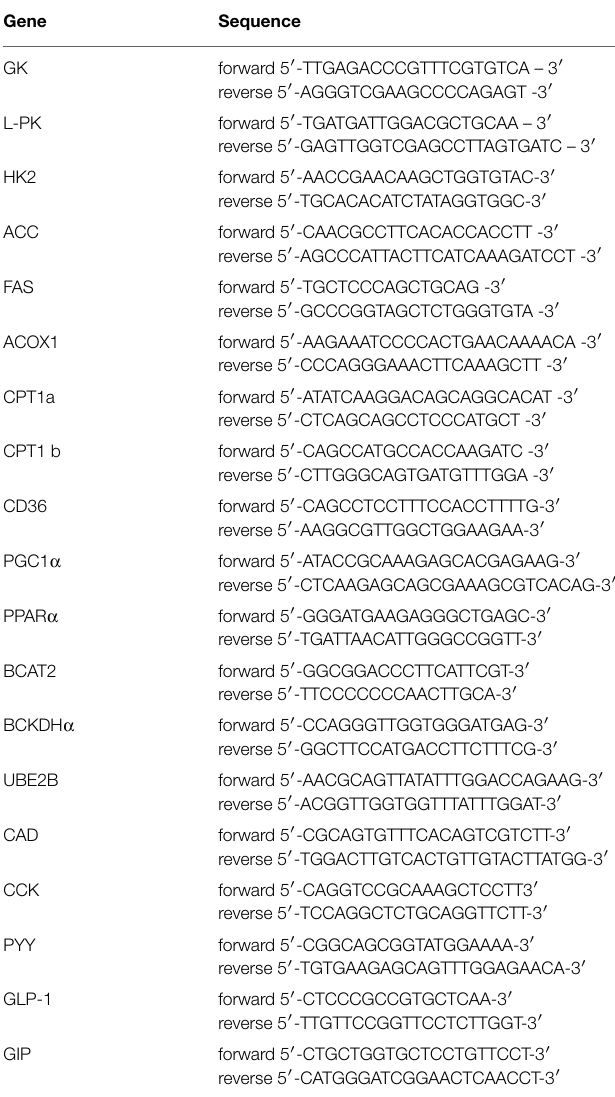
TABLE 2 | Primer sequences used for liver, muscle, adipose tissue, and intestine mRNA analysis